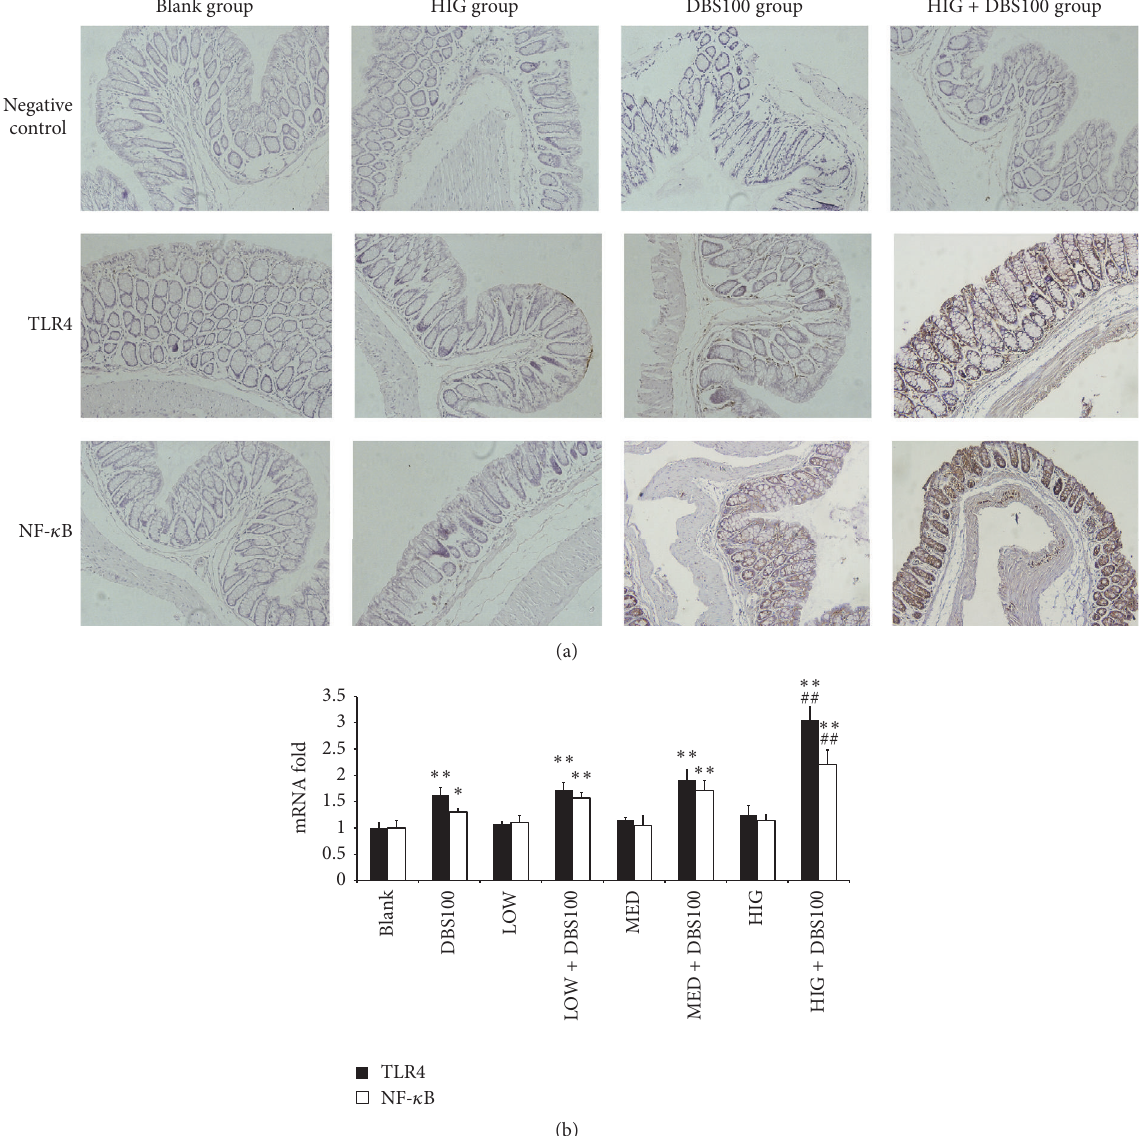
Figure 10: The impact of 𝜅 -carrageenan on the secretion of TLR4 and NF- 𝜅 B in the colonic mucosa of experimental mice. (a) The effect of 𝜅 -carrageenan on the secretion of TLR4 and NF- 𝜅 B in mice, × 200 fold. (b) The impact of 𝜅 -carrageenan on the expression of TLR4 and NF- 𝜅 B at the mRNA level. ∗ 𝑃 < 0.05 , ∗∗ 𝑃 < 0.01 , compared with the blank group. ## 𝑃 < 0.01 , compared with the Citrobacter freundii DBS100-treated